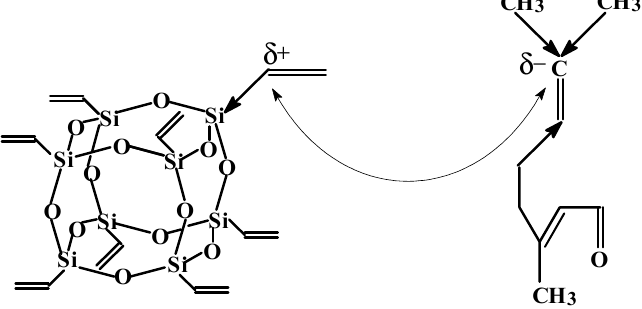
Scheme 2. The polarity effects on the double bonds of both VS and citral for the connection: Si is an electron-attracting atom and C is an electro-donating atom, which two C atoms in the VS and citral possess positive and negative charges,